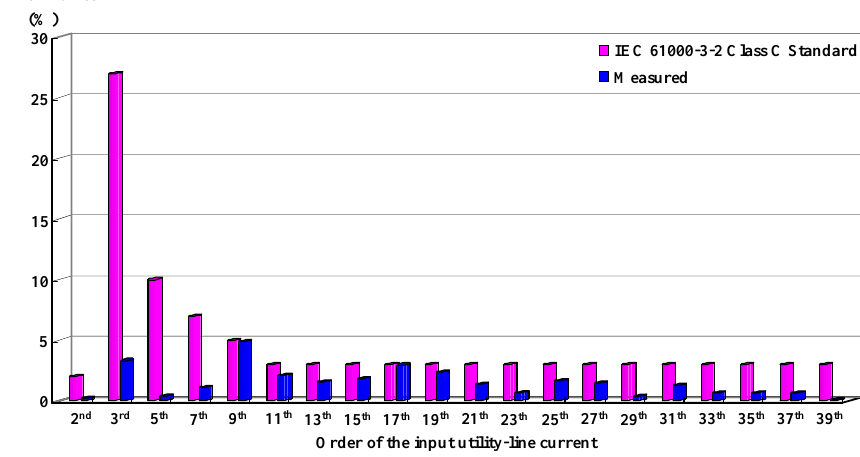
Figure 14. Measured input current harmonics compared with the IEC 61000-3-2 Class C standards.